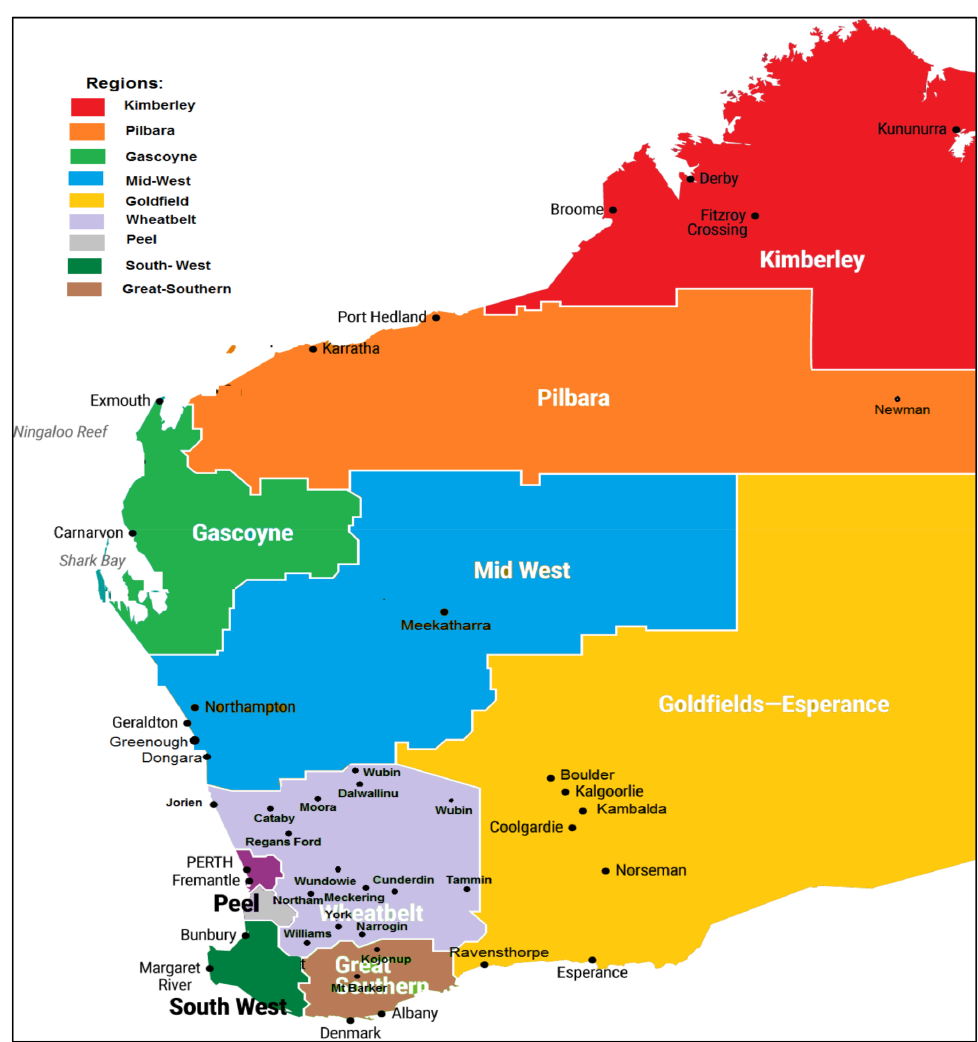
Figure 1. Local government cities and regional boundaries. Source: Western Australia Mineral and Petroleum: Statistics Digest 2016–2017, p.